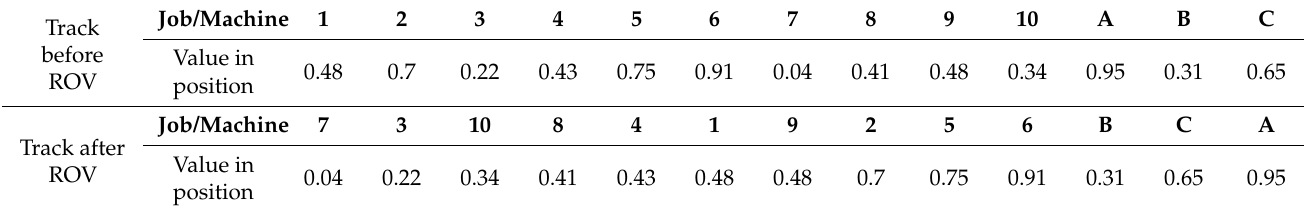
Table 3. Track 1 before and after applying rank order value